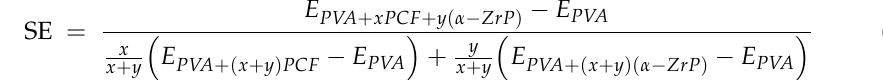
Table 1. SE values of aerogel with TGA data.